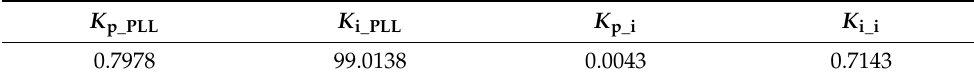
Table 3. Parameters of systems of the GFL